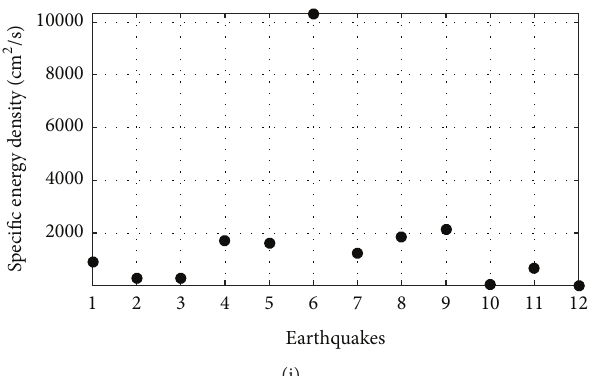
Figure 3: Characteristics of the utilized ground